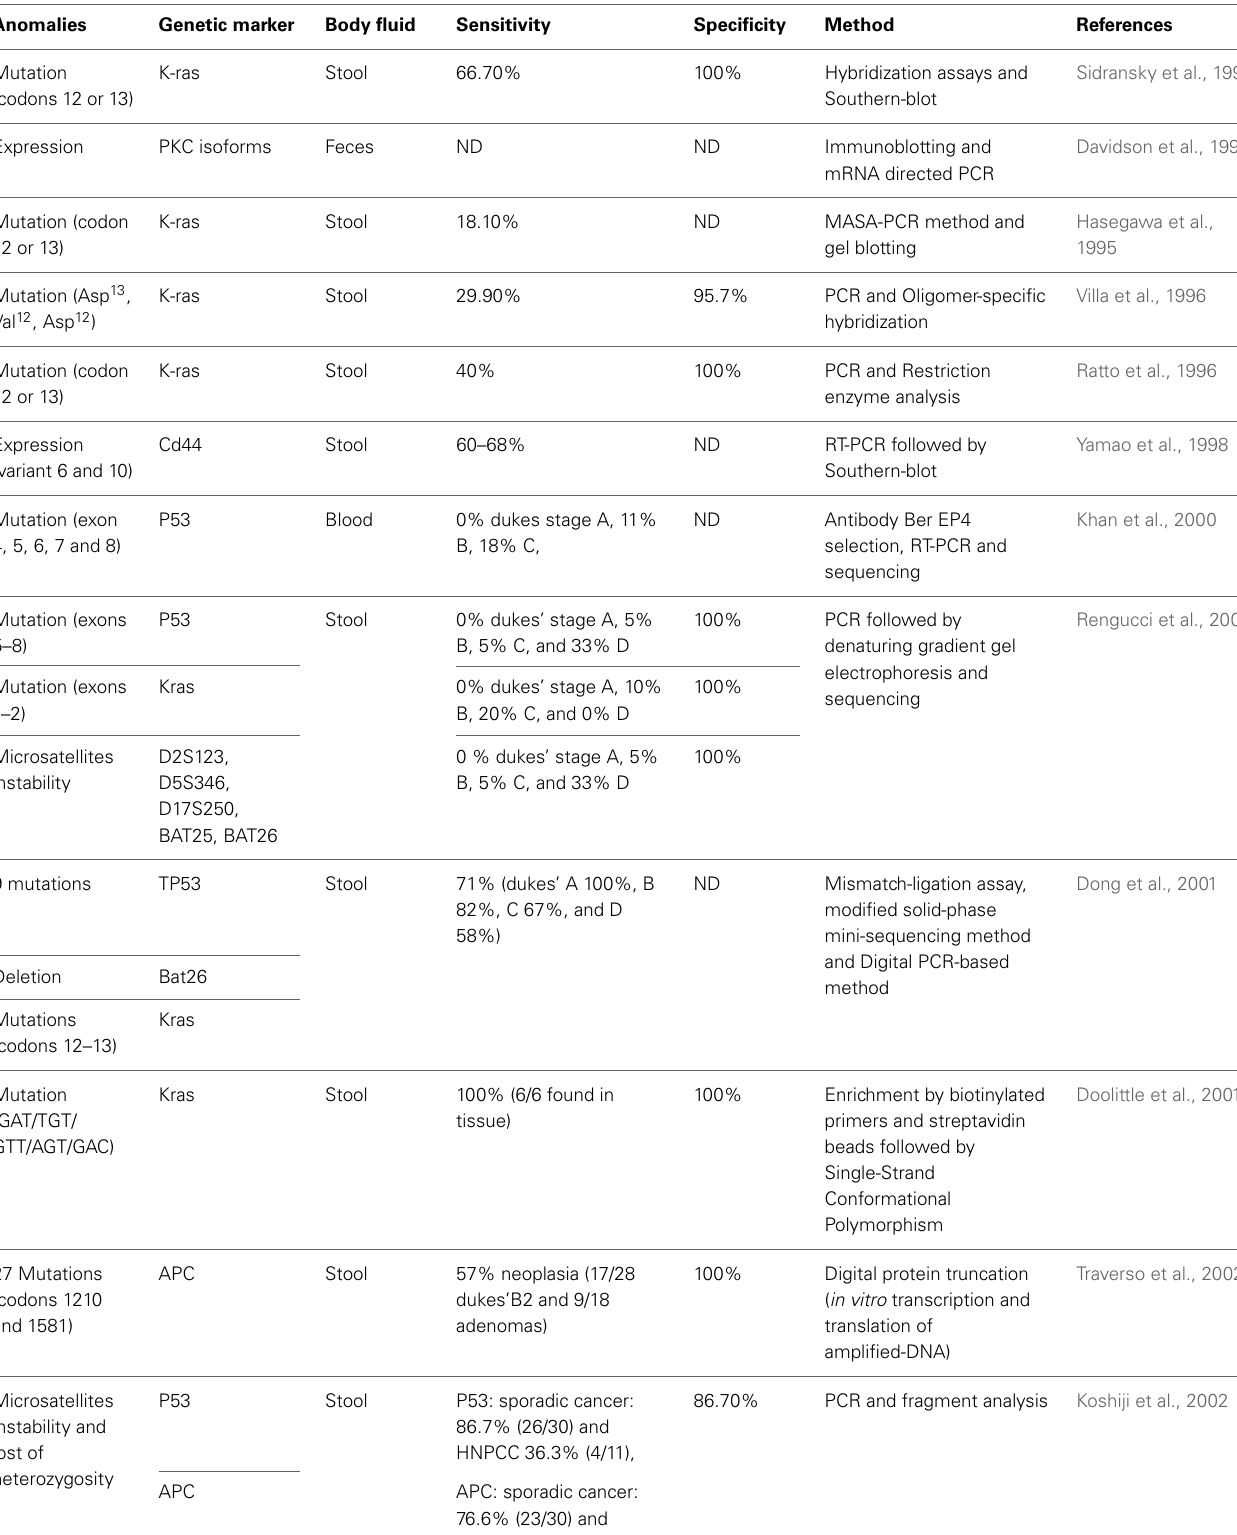
Table 1 | Summary of genetic markers found in body fluids from CRC